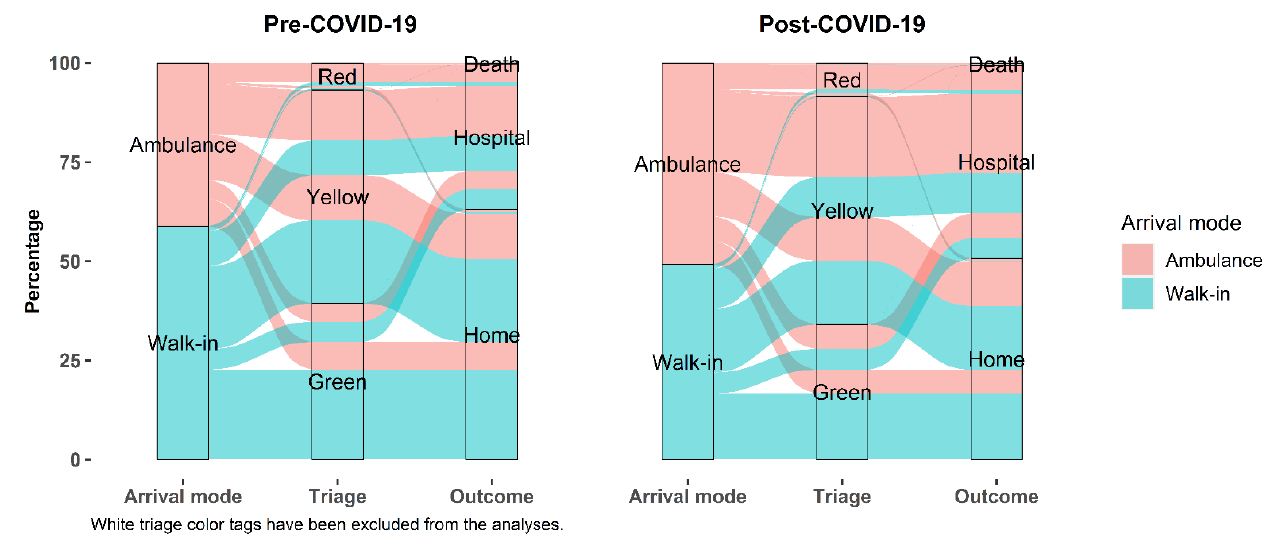
Figure 4. Proportion of emergency department visits by access mode, triage code, and outcome, in the pre-pandemic period (briefly referred to as “Pre-COVID-19”, from January 2019 to February 2020) and after the pandemic started (briefly referred to as “Post-COVID-19”, from March 2020 to December 2020). Visits with a white triage code were removed to better appreciate the most relevant changes between the two years for more severe medical conditions (i.e., red, yellow, and green triage codes). Any ED trajectory that included missing data on arrival or discharge mode, or any trajectory that included a white color code was excluded from the analyses (n = 414,539). Orange color codes introduced in 2020 were converted into yellow codes for consistency with the rest of the study period.